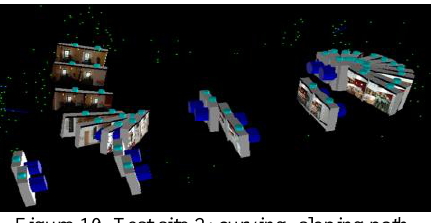
Figure 10. Test site 2: curving, sloping